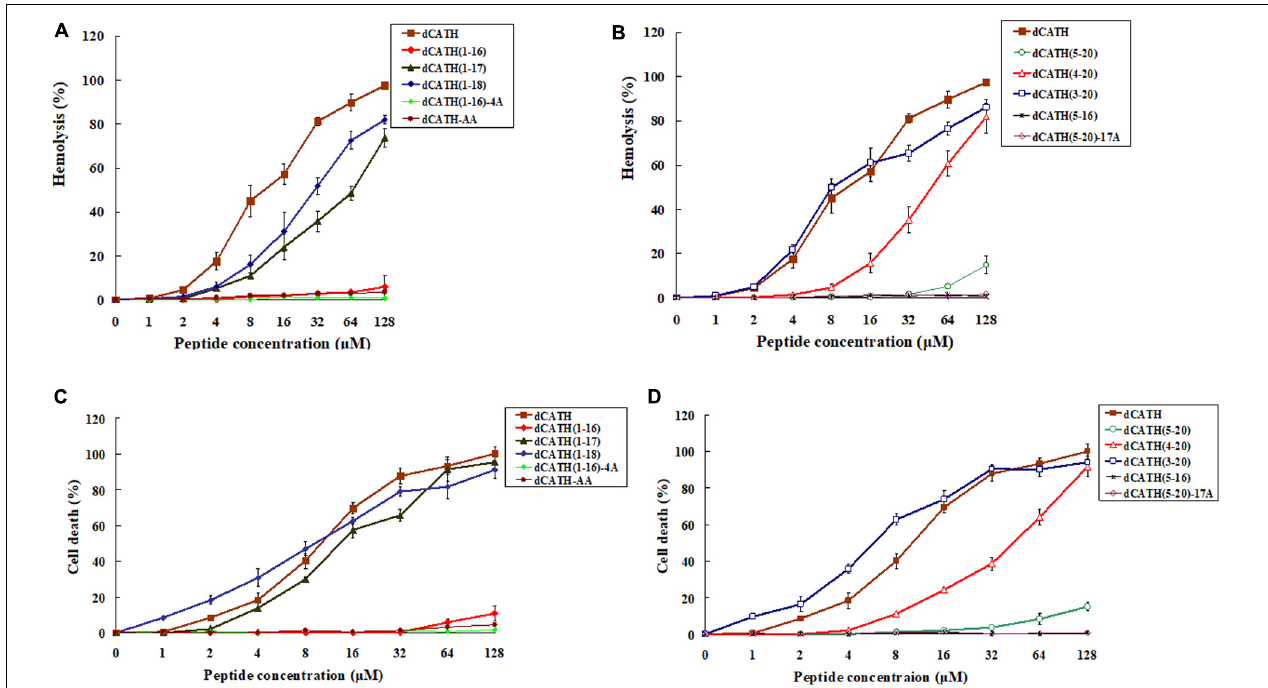
FIGURE 1 | Hemolytic and toxicity activity of the peptides. (A,B) Hemolytic activity against hRBCs. (C,D) Toxicity activity against RAW264.7 cells. Hemolytic activity was evaluated by incubating individual peptides in serial 2-fold dilutions with freshly isolated hRBCs at 37 ◦ C for 1 h, followed by measuring the released hemoglobin at 405 nm. For negative and positive controls, hRBCs in PBS and 0.1% Triton X-100 were used, respectively. Toxicity activity of the peptides against RAW264.7 was determined using MTT method. The peptides were incubated with RAW264.7 in a 96-well microtiter plate. After incubation with MTT, the supernatant was discarded and DMSO was added and the optical density (OD) at 570 nm was measured. TABLE 2 | MIC, MHC, and TI of the peptide dCATH and its derivatives.